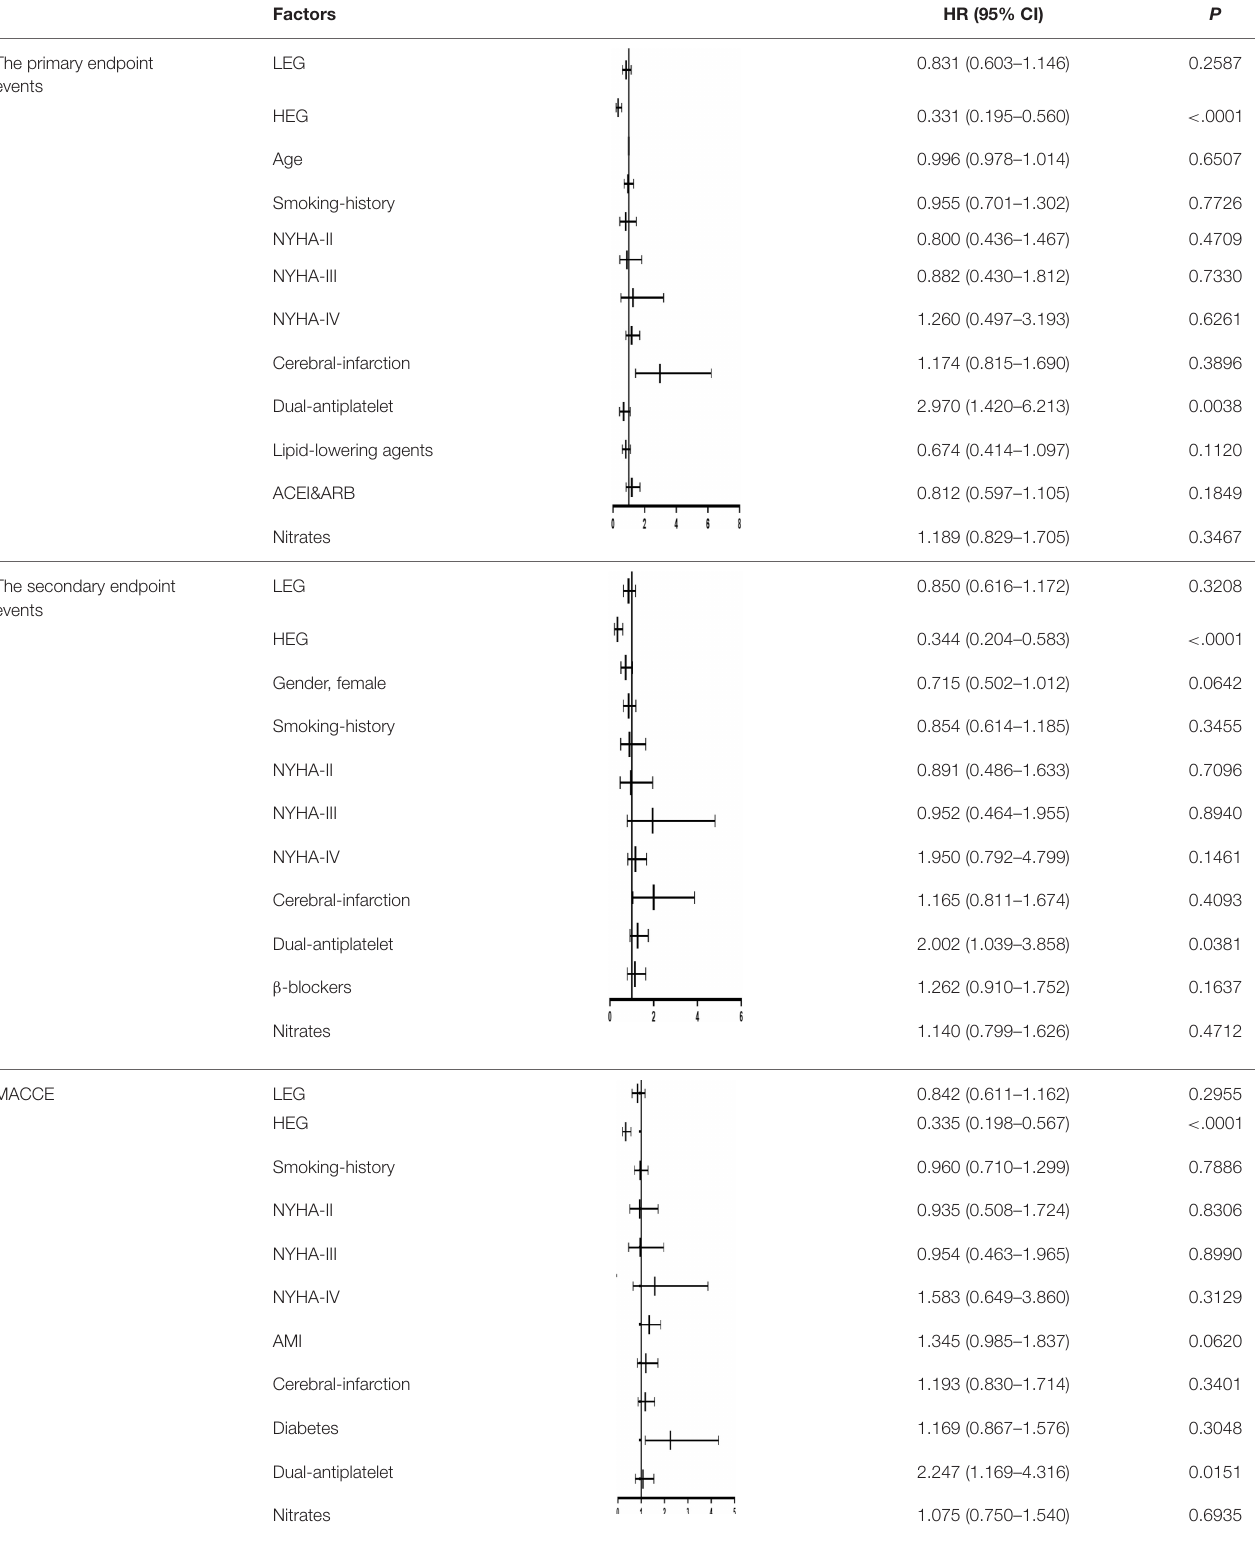
TABLE 3 | The relationship between the multivariate factors and CHD analyzed by the Cox regression models.